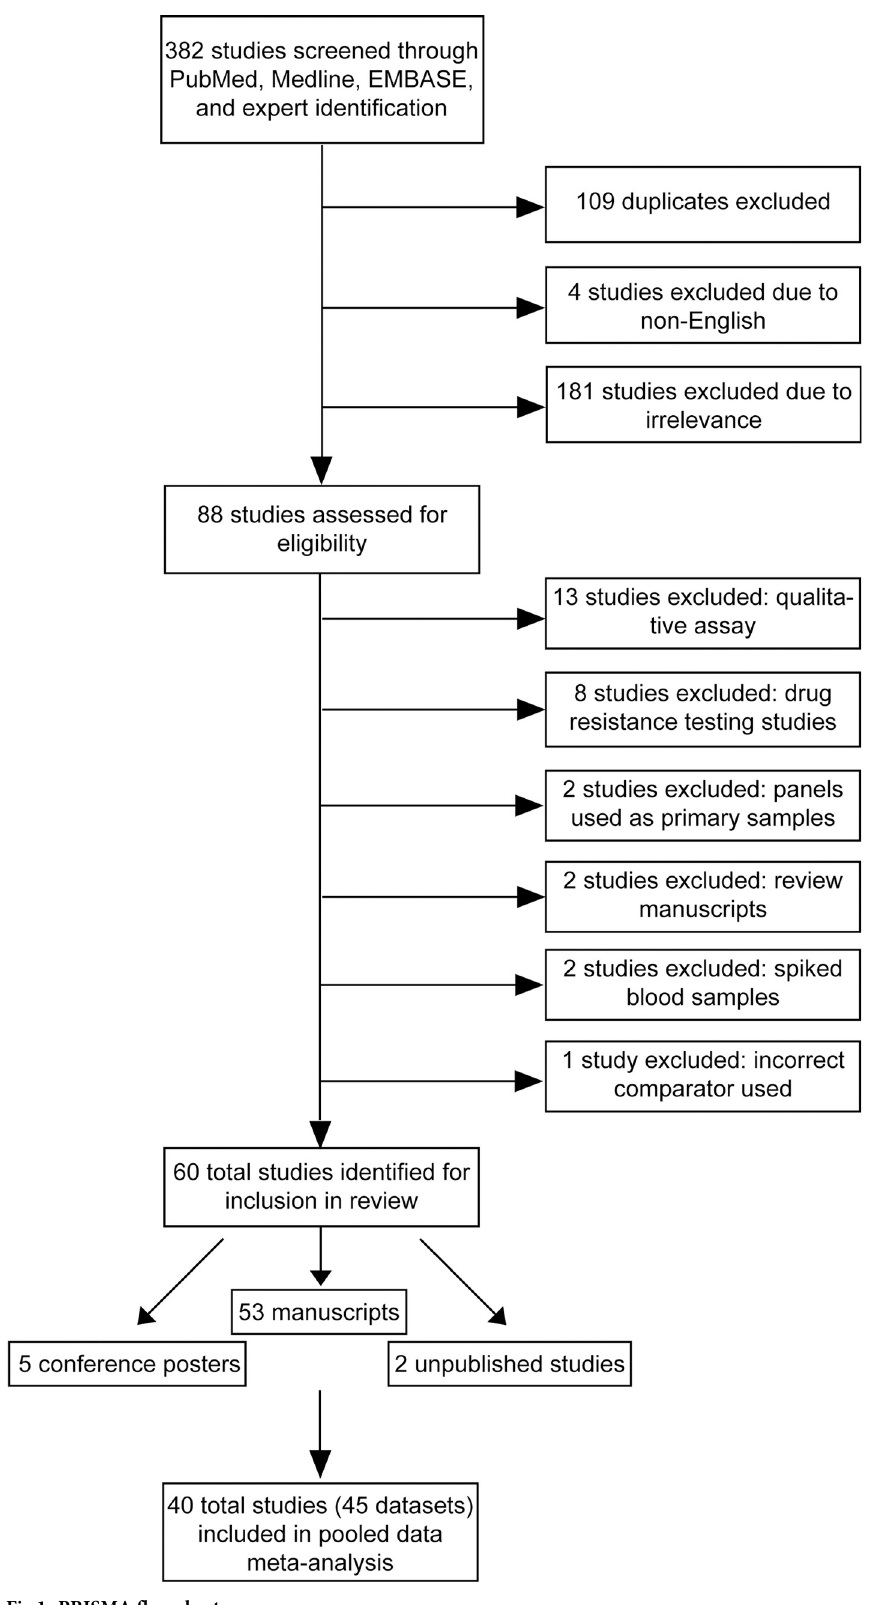
Fig 1. PRISMA flow